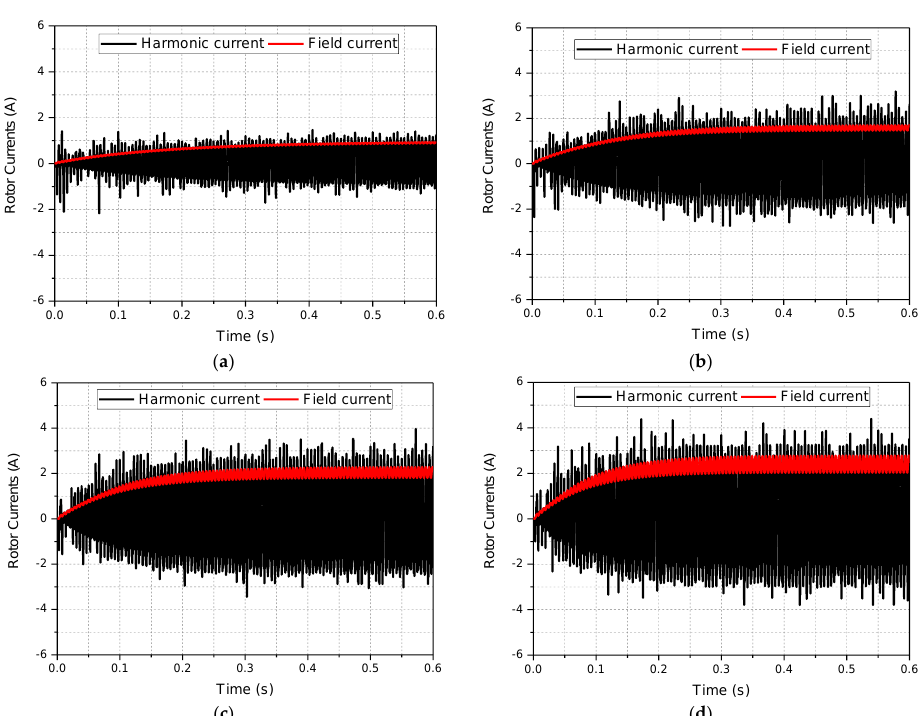
Figure 9. Rotor currents of the machine having ( a ) 0.6 A, ( b ) 1.2 A, ( c ) 1.8 A, and ( d ) 2.4 A dc offset for each phase of armature currents.